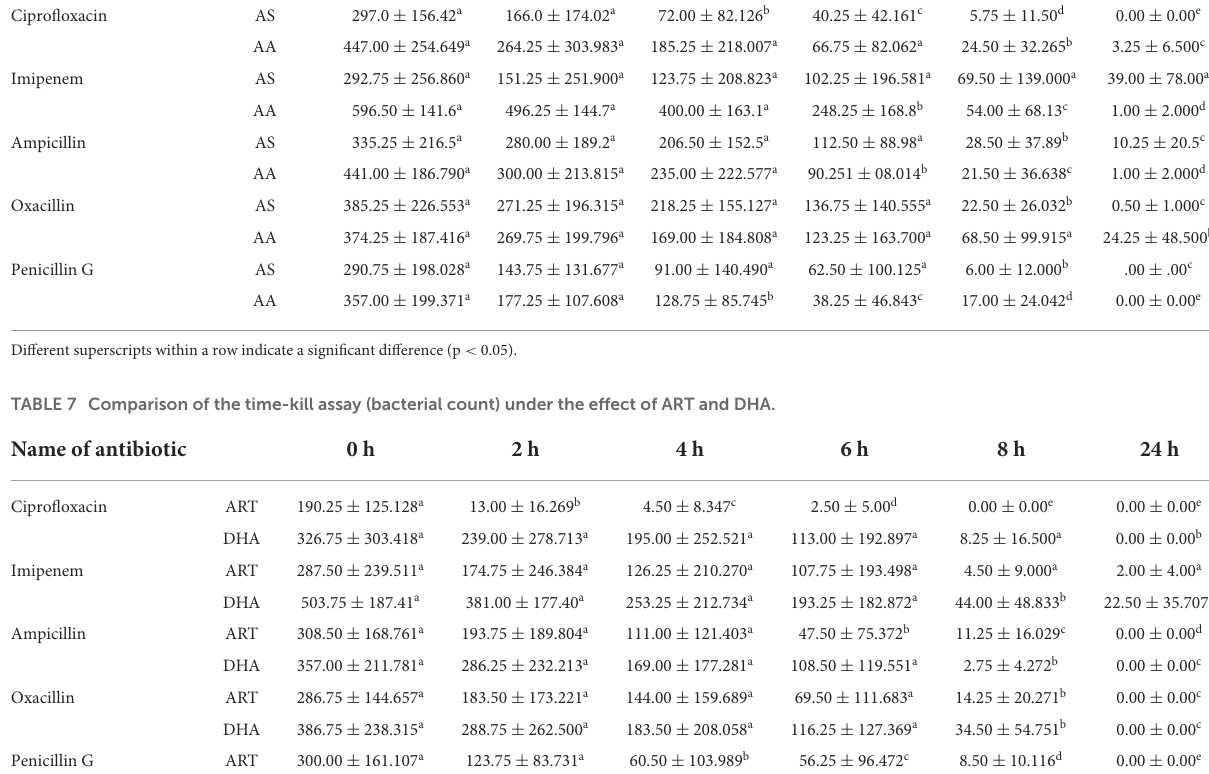
TABLE 6 Comparison of time kills assay (bacterial count, CFU/ml) under the effect of AS and AA. Name of antibiotic